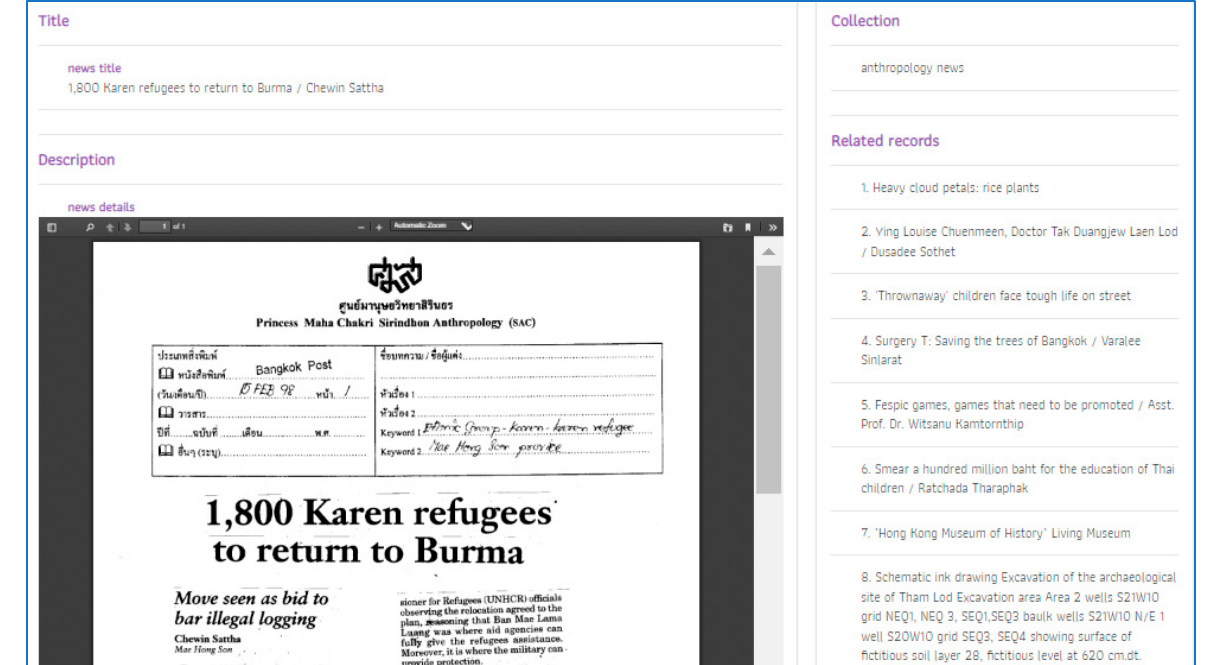
Figure 3. An example of unified resource representation on the SAC One Search system.